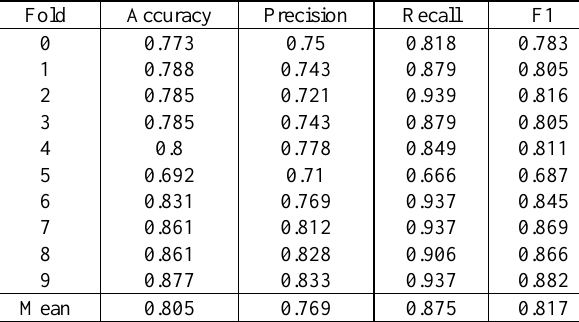
Table2 . Accuracy metrics of all folds for the ensemble model.